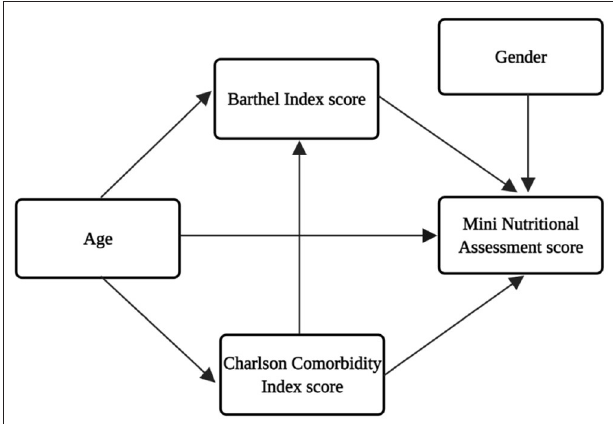
FIGURE 1 | Theoretical model for the interrelationships of the factors that influence nutritional status (MNA score).